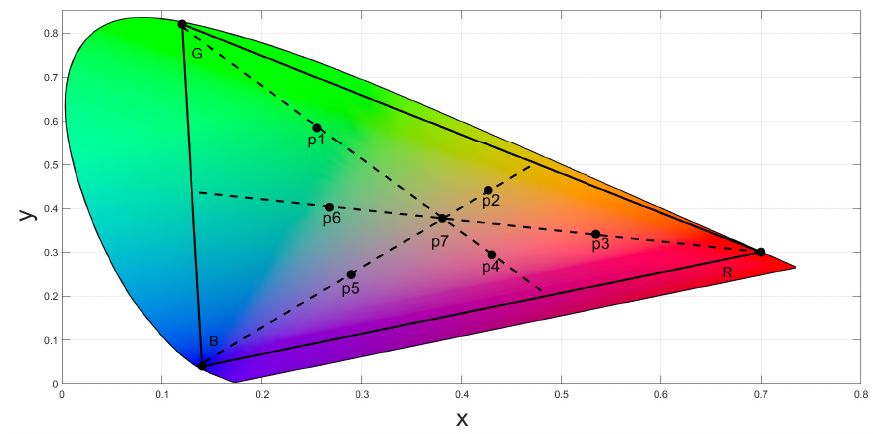
Figure 4. CIE 1931 chromatic points to explore in the VLP system based on RGB